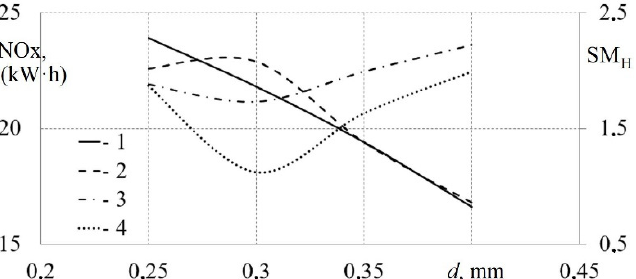
Figure 6. Dependences of the amount of NOx emissions and smokiness of the exhaust gases SMH on the diameter of holes d in the nozzle of a diesel injector at different modes: 1—NOx = f ( d ) at the nominal engine mode; 2—NOx = f ( d ) at idle; 3—SM H = f ( d ) in the nominal mode; 4—SM H = f ( d ) at idle.